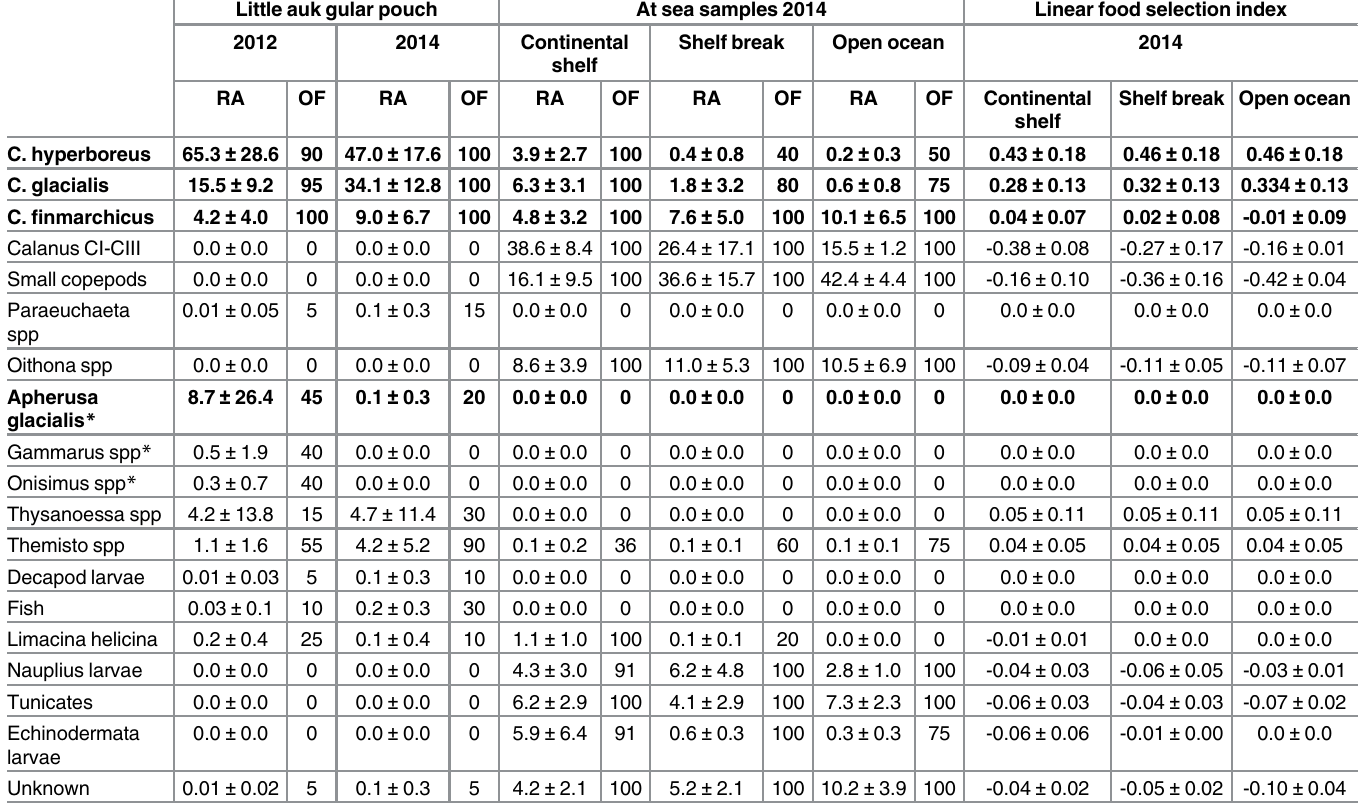
Table 2. Relative abundance (RA, mean ± SD, %) and occurrence frequency (OF, %) of zooplankton found in little auk gular pouches in 2012 and 2014, and in at-sea samples collected in 2014; and linear food selection index (mean ± SD, %) for 2014 prey. Calanus hyperboreus , C . glacialis and C . finmarchicus groups included the stages CIV, CV, and adult males and females. Other copepodite stages of these 3 species were included in the ‘ Calanus CI-CIII ’ group. Species included in the ‘ small copepods ’ group are Triconia borealis , Scaphocalanus magnus , Metridia longa and Microcalanus spp for the Continental shelf, and Triconia borealis , Metridia longa and Microcalanus spp for the shelf break and the open ocean. Main little auk prey species are in bold. Asterisk indicates ice-associated prey. Continental shelf, shelf break and open ocean groups were defined based on isobaths ( < 500 m, 500 – 1500 m and > 1500 m respectively). Linear food selection index is the difference between prey proportion found in little auk gular pouch and prey proportion in the environment and ranges from -1 to 1 [38]. A positive value indicates preference and negative or null values avoidance or